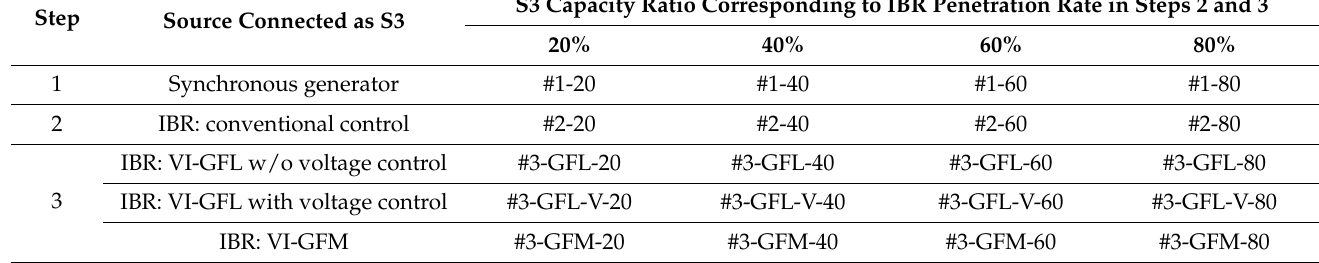
Table 1. Indices of the simulation study.